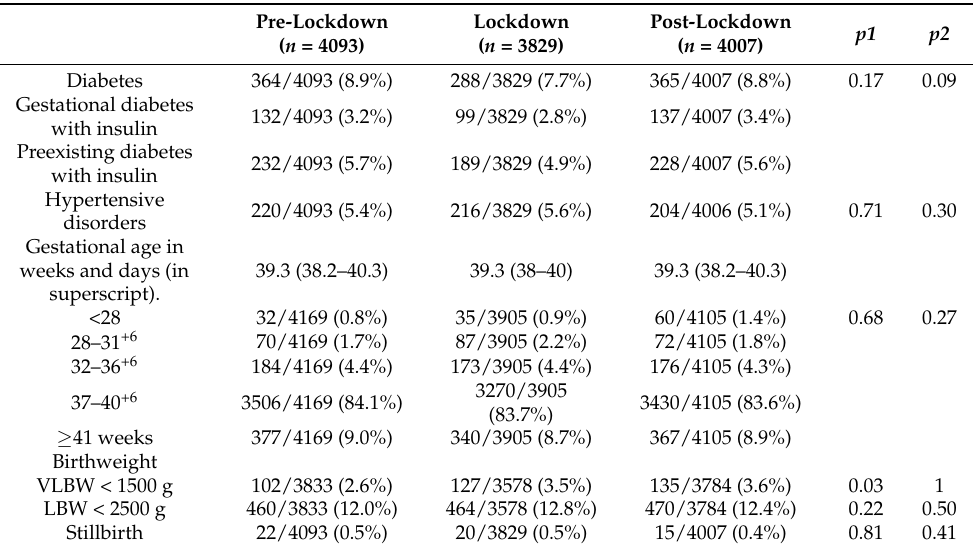
Table 2. Comparison of perinatal outcomes between the three